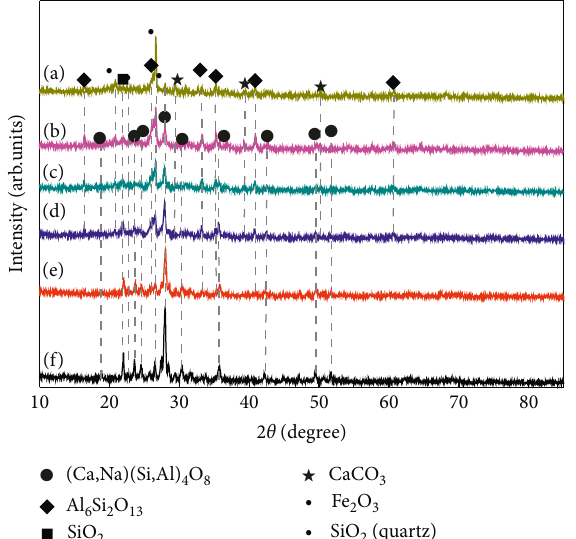
Figure 11: XRD patterns of (a) the mixed powder and the sintered samples at (b) 950 ° C, (c) 1000 ° C, (d) 1050 ° C, (e) 1100 ° C, and (f) 1150 ° C.